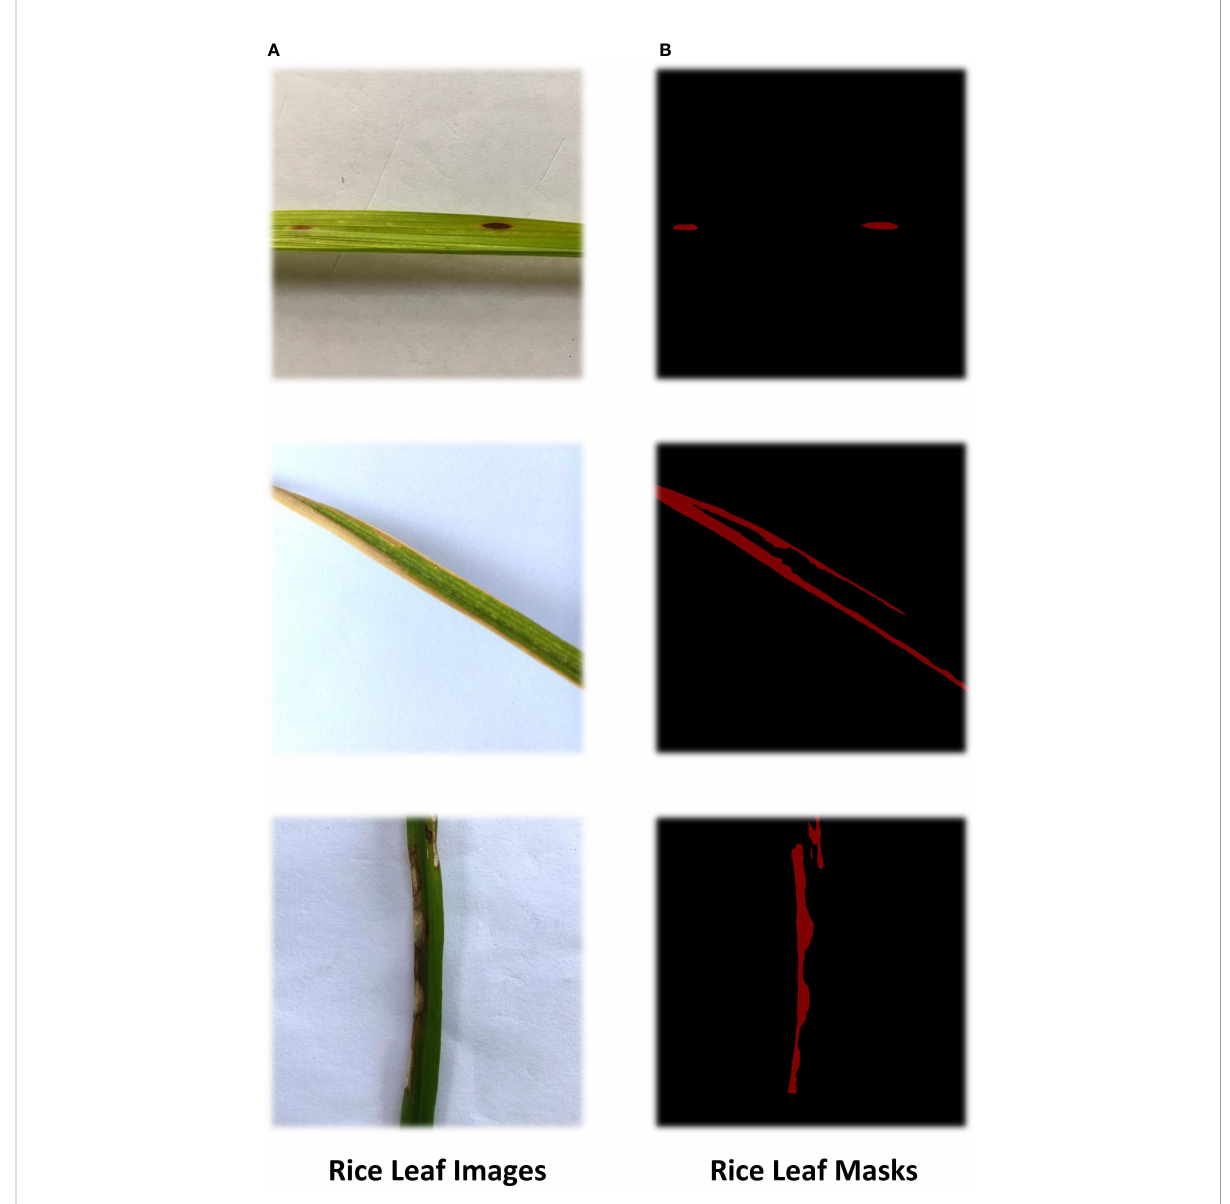
FIGURE 3 Masks of rice leaf. Rice leaf images were labeled by Labelme to generate masks.The original pictures are shown in (A) , the red areas in (B) is the diseased